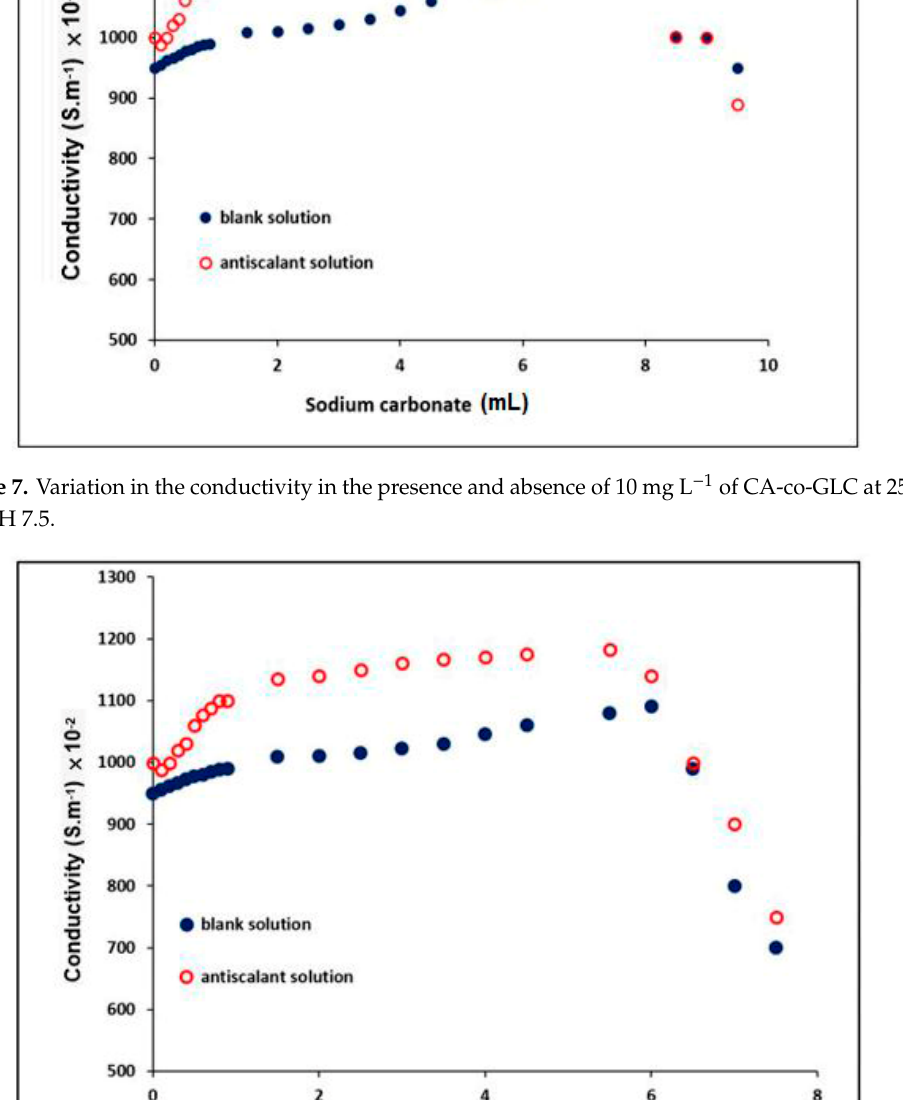
Figure 9. Variation in the conductivity in the presence and absence of 10 mg·L − 1 CA-co-GLC at 25 °C and pH 9.